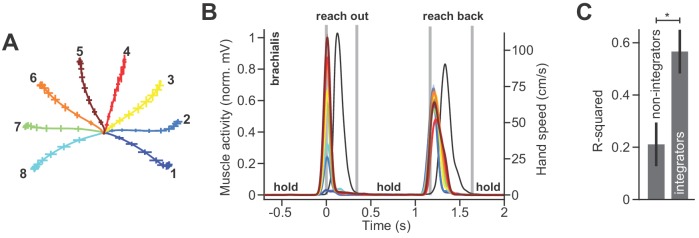
Muscles that do not integrate also do not contribute to posture.(A) Two monkeys performed a reaching task in the vertical plane. The monkeys reached out to one of eight targets, waited, and then reached back to the home position. Trajectories for the outward reach are shown. (B) Normalized activity of brachialis in Monkey B. Colors correspond to targets in A. We selected this representative muscle to demonstrate that some muscles show little to no holding activity at most, if not all, targets. These muscles all tend to show early moving activity, well before peak speed, and then cease activity around halfway through the movement. The hand speed is shown in black. (C) We selected muscles that have little to no holding activity, that is those whose activity during the hold period has a magnitude less than 10% of the peak moving activity. There are 6 out of 20 muscles who had such a property for most, if not all holding locations. We quantified the change in holding activity (from before to after the movement) and the integral of moving activity. We asked how well the integral of moving activity predicted the change in holding activity (the variance accounted for, or R2) in muscles with little holding activity (non-integrators) and others that were more active during holding still (integrators). Error bars are SEM. Statistics: *p<0.05.